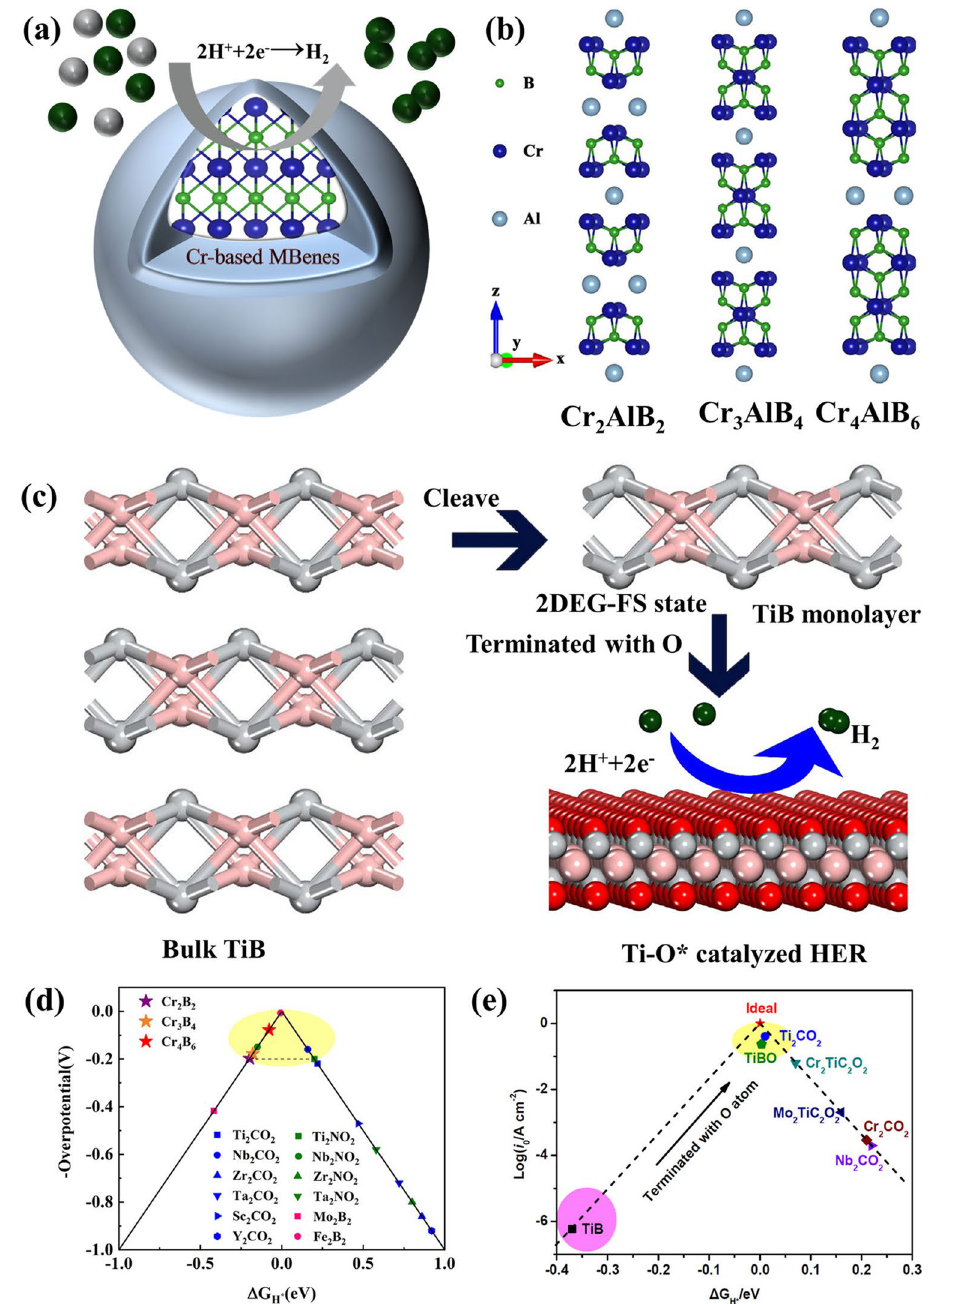
Fig. 9 a Schematic illustration of the reaction pathways of hydrogen evolution reaction on the Cr n+1 B 2n catalyst surface. b Crystal structures of Cr 2 AlB 2 , Cr 3 AlB 4 and Cr 4 AlB 6 . Reproduced with permission from Ref. [146]. c Sketch of the HER process catalyzed by TiB; The TiB mon- olayer cleaved from bulk TiB for the study of electronic properties and reactivity; The TiB layer with surface functionalization for HER. Repro- duced with permission from Ref. [152]. d HER volcano curve of Cr n+1 B 2n (stars) compared with some previously reported MXenes and MBenes at H coverage of 1/4 ML. Reproduced with permission from Ref. [146]. e The calculated exchange current (log i 0 ) plotted as a function of H * adsorption free energy on different MXenes/MBenes. Reproduced with permission from Ref.